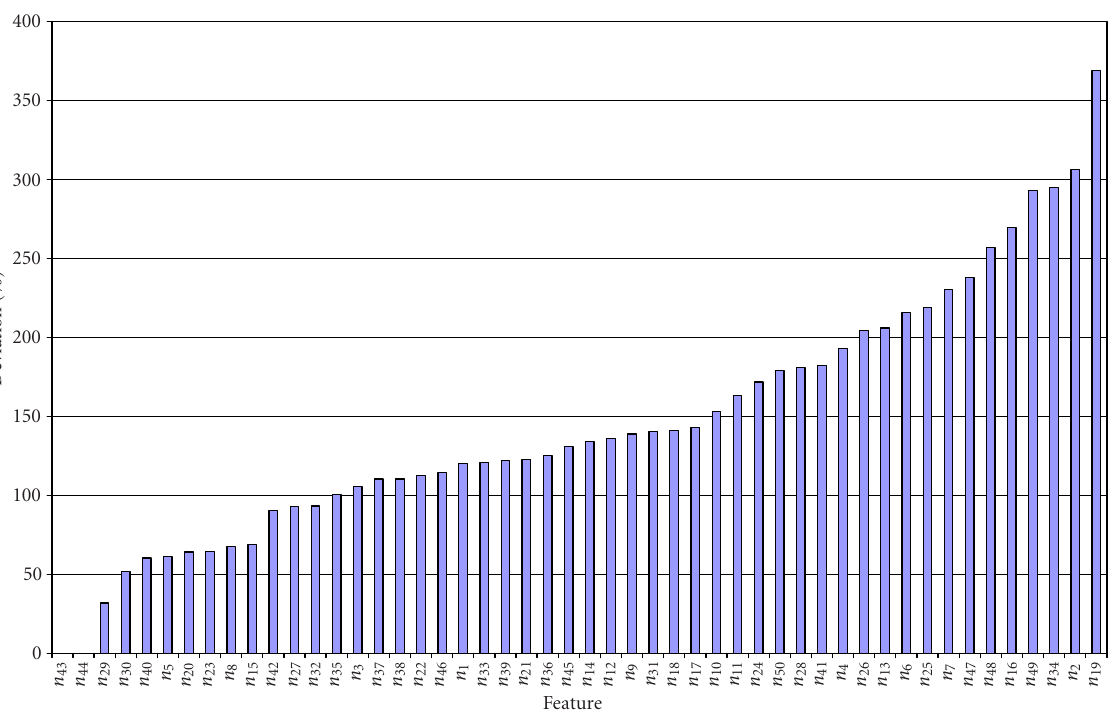
Figure 2: Sorted histogram of average deviation d i in feature values of signatures with e = 6 in initial